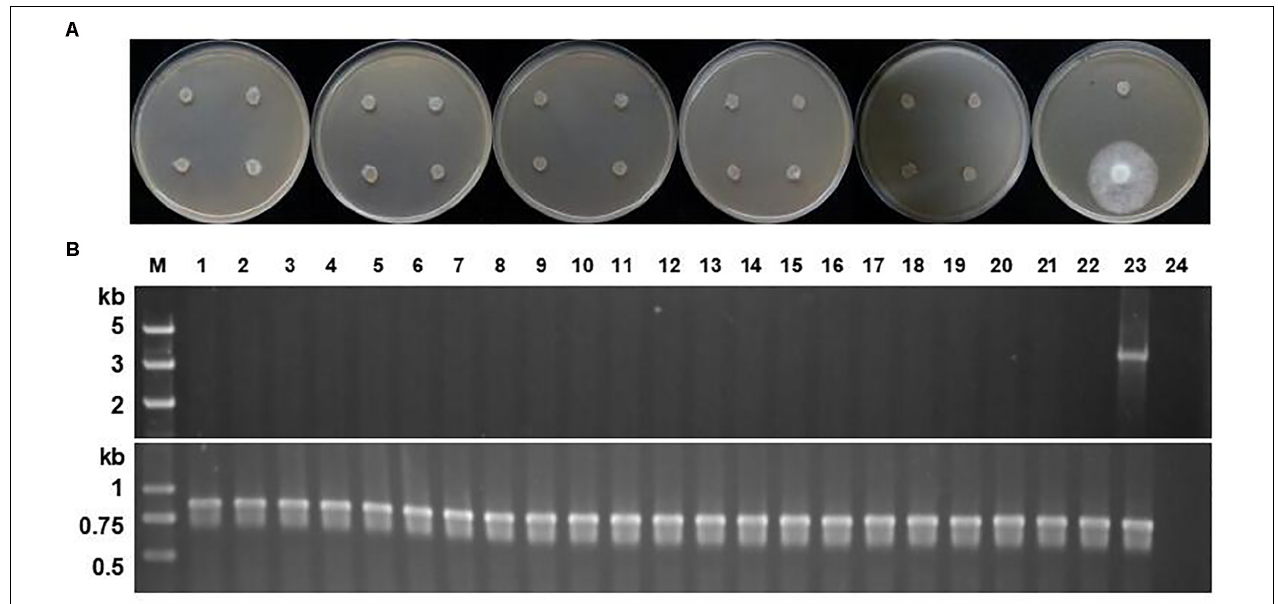
FIGURE 4 | Stability of the PcMuORP1 selection marker in P. sojae. (A) Growth of the 21 P. sojae transformants from 10 successive rounds of vegetative subculture in the absence of selection pressure on V8 media amended with 0.01 µ g/ml oxathiapiprolin after 3 days dark-incubation at 25 ◦ C. The last isolate which could grow in the presence of oomyceticide was the one maintained on oxathiapiprolin-amended V8 medium. (B) PCR analysis for the detection of the PcMuORP1 gene. Top: PcMuORP1 -specific primers. Bottom: Actin-specific primers. Lanes 1–21, 21 P. sojae transformants after 10 successive rounds of vegetative subculture in the absence of selection pressure; Lane 22, Wild-type isolate P6497 used as a negative control; Lane 23, P. sojae transformant maintained on oxathiapiprolin-amended V8 medium; Lane 24, Blank